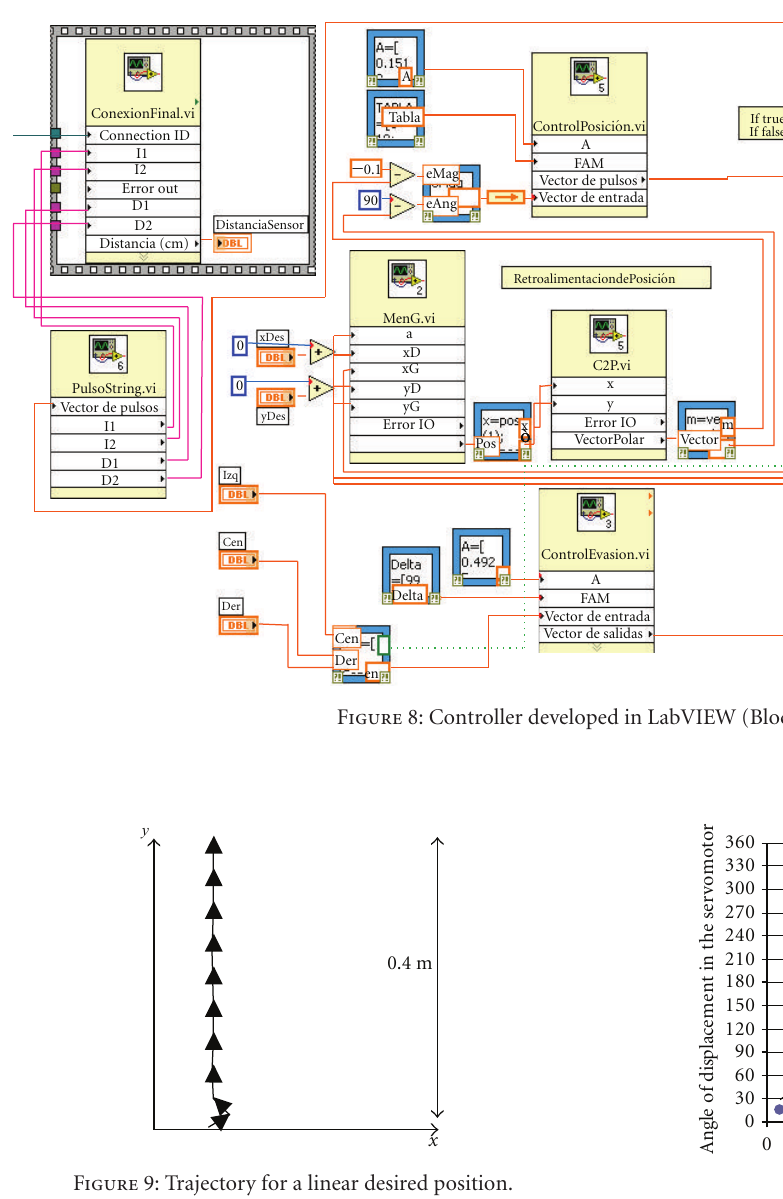
Figure 11: Measurement of angles in the servomotor.